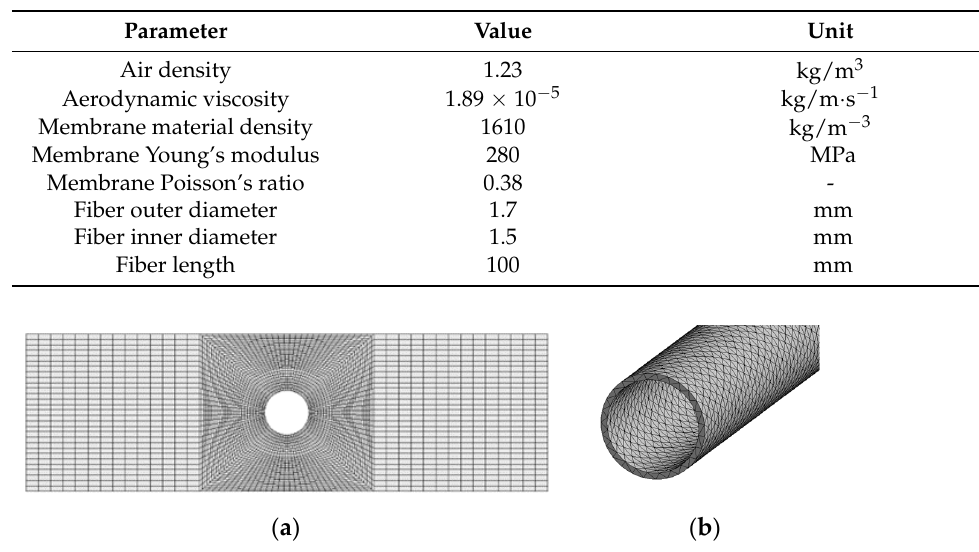
Figure 2. Meshing Diagram: ( a ) Fluid domain local mesh; ( b ) Solid domain local grid. Table 2. Mesh independence